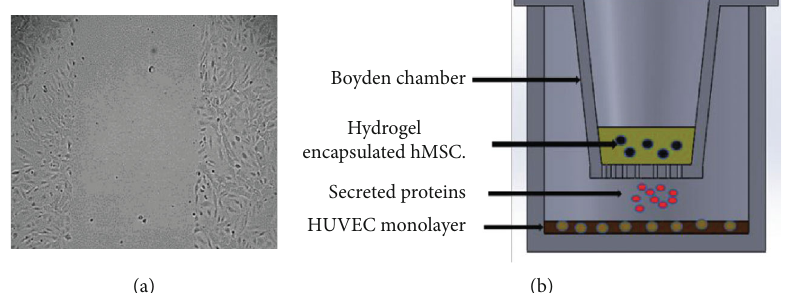
Figure 1: (a) Initial wound of HUVEC monolayer made by the Woundmaker. (b) Schematic representation of the coculture of HUVEC with hydrogel-encapsulated hMSC seeded in a Boyden chamber. Both cells were incubated in alpha MEM 0.2%